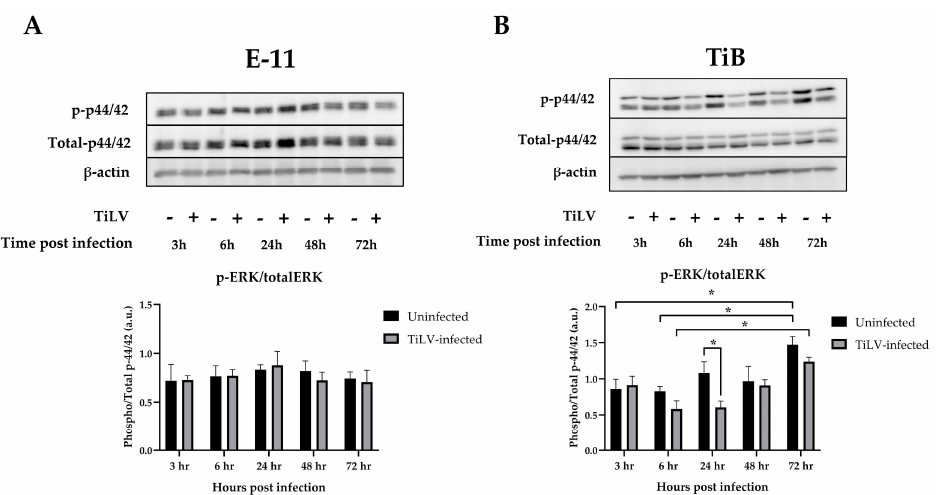
Figure 3. The determination of ERK phosphorylation (p-ERK) in ( A ) the E − 11 cells and ( B ) TiB cells following TiLV infection (n = 3 each). The results demonstrate a significant suppression of p-ERK in the TiB cells at 24 hpi ( B ). The data are presented as means ± SEMs with * p <